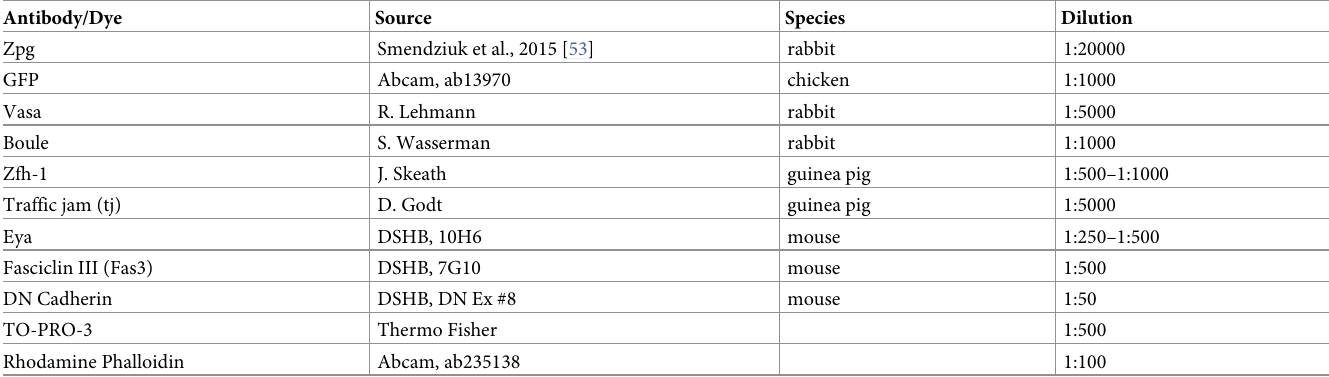
Table 2. Antibodies used in this